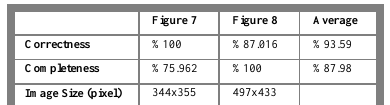
Table 2: Evaluation of results for Non-Salient Roads Using Ribbon Snake